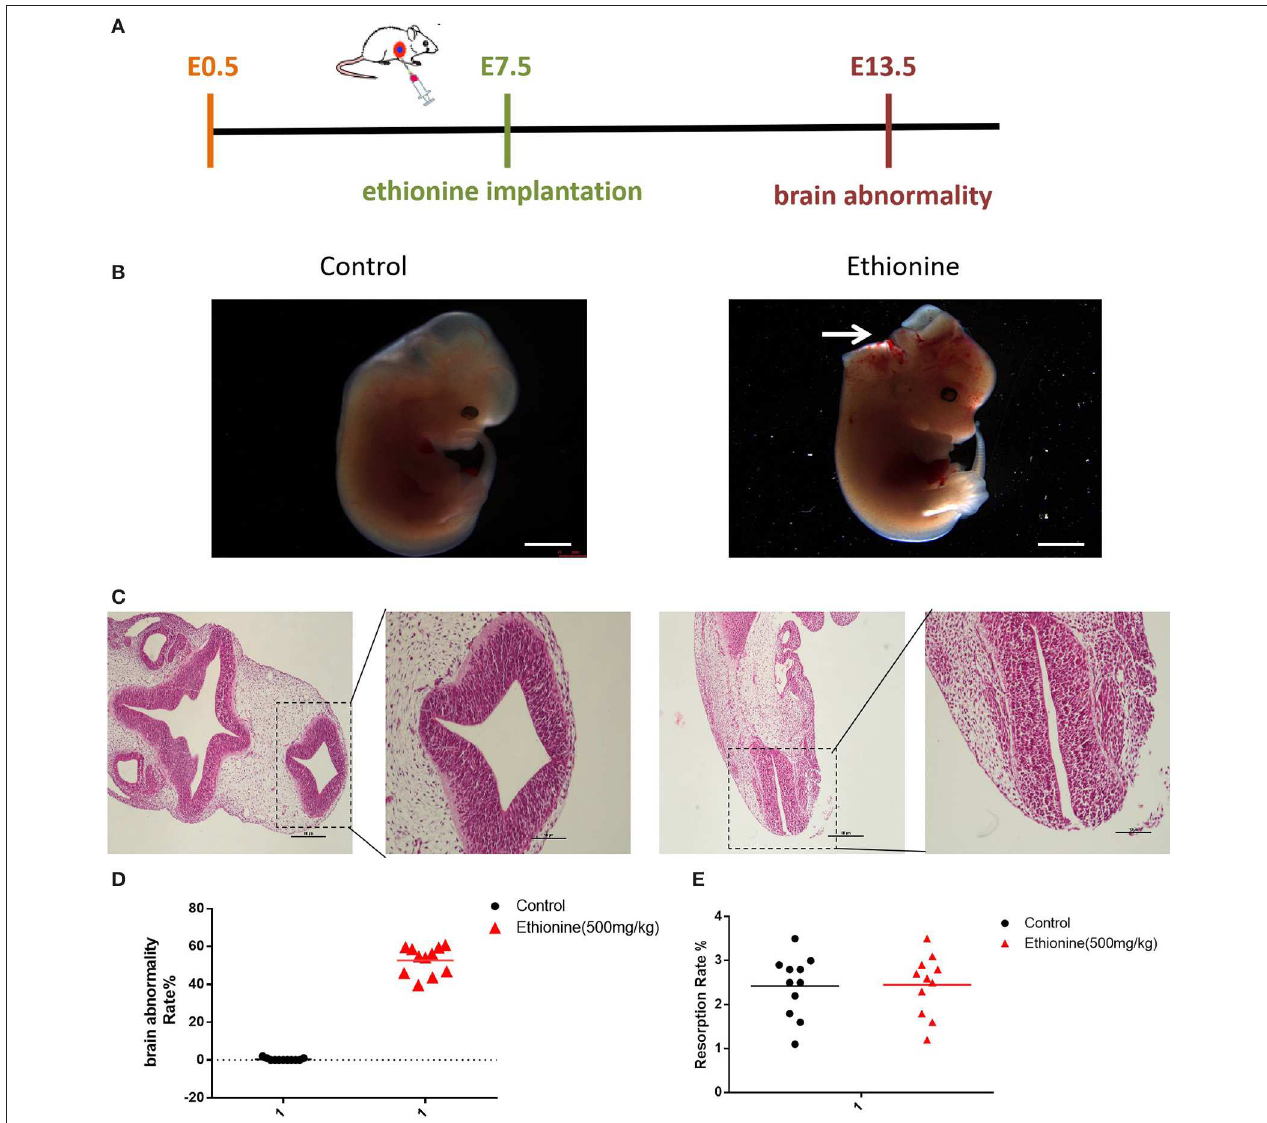
FIGURE 1 | Ethionine induced NTDs. (A) The ethionine treatment schematic diagram. Ethionine was injected intraperitoneally at E7.5 and embryos were isolated and extracted at E13.5. (B) Morphology of E13.5 embryos and histological view of the neural tubes (NT) 50 × . (C) Photomicrographs of coronal sections of normal embryos and NTD embryos using hematoxylin and eosin staining. Scale bars: 100 µ m. (D) Brain abnormality rates in C57BL/6 mice with or without ethionine. Incidence rates were calculated by embryos. (E) Absorption rate in C57BL/6 mice with or without ethionine. Each experiment was carried out in triplicate ( n =